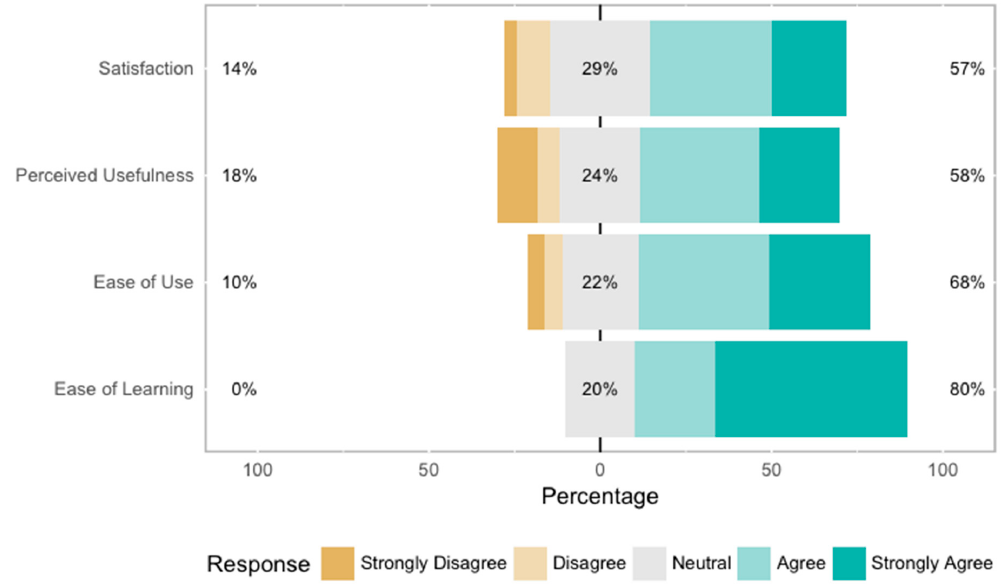
Figure 14. Results of the USE questionnaire according to the four categories: satisfaction, perceived usefulness, ease of use and ease of learning.